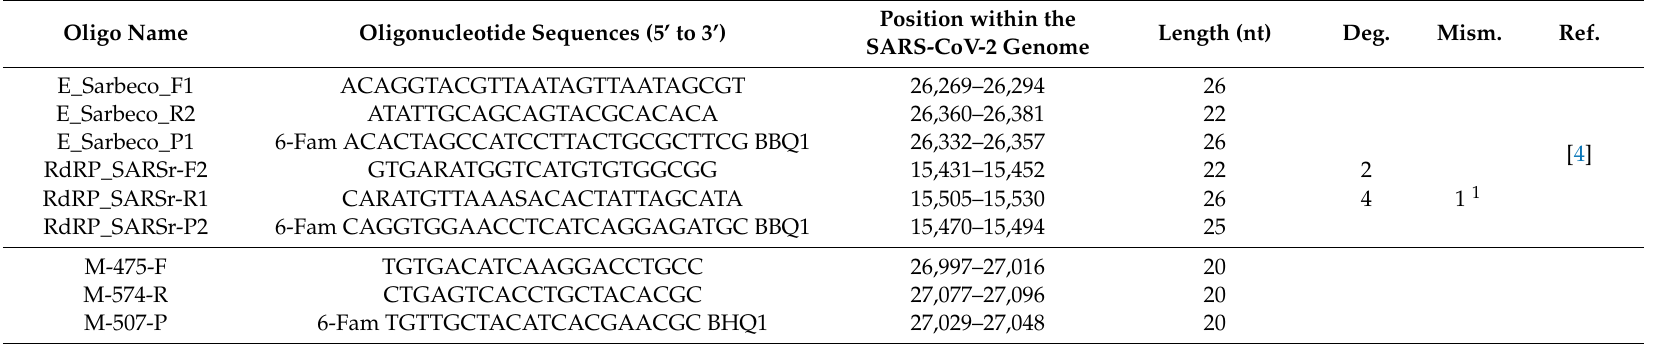
Table 1. Oligonucleotides used for the detection of SARS-CoV-2 RNA.